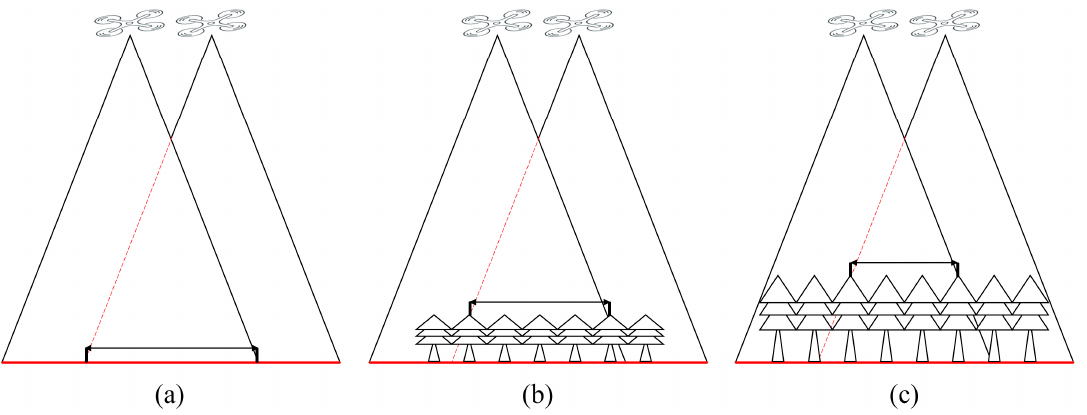
Figure 6. Example of the influence of tree height on the overlaps for UAV images in a ( a ) non-forest area; ( b ) forest with low tree height; and ( c ) forest with high tree height.